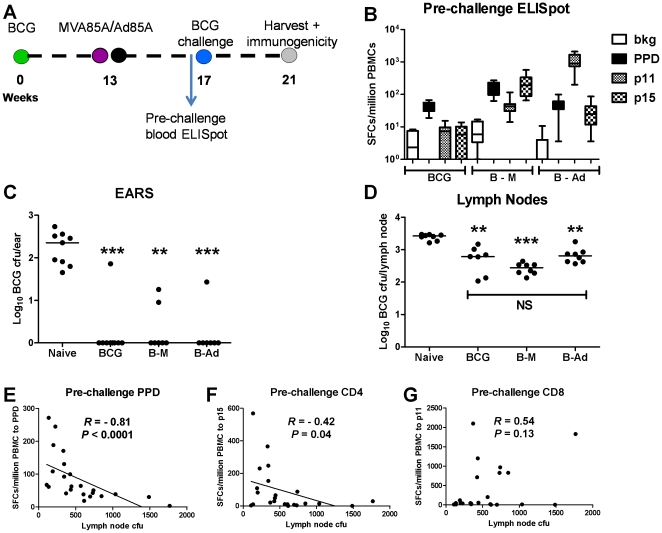
Effect of BCG, BCG-MVA85A (B–M), and BCG-Ad85A (B-Ad) prime-boost regimes on an id BCG challenge.Timeline shown in (a): BALB/c mice were immunized with 104 CFU BCG id and then boosted after 13 weeks with either 1×106 pfu MVA85A id or 2×109 vp Ad85A id. All animals were challenged 4 weeks later with 6×103 CFU of BCG id. Organs were harvested 4 weeks after challenge. Log10 BCG CFU of challenge are shown in (c) Ears (***P<0.001, **P<0.01, n = 8); and (d) LNs (***P<0.001, **P<0.01, n = 8, “NS” = no significant difference). **/*** indicate significance of immunization regimes over naïve mice. (b) Pre-challenge immunogenicity as measured in the blood by ELISpot. IFN-γ responses were assessed after stimulation with PPD, a H-2d CD4+ T cell epitope, and a H-2d CD8+ T cell epitope present in the M.tb antigen 85A, on blood samples taken one day pre- BCG challenge. IFN-γ responses within all three vaccinated groups (BCG (B), BCG-MVA85A (B-M), and BCG-Ad85A, (B-Ad), n = 10) are shown. Whiskers represent minimum to maximum values, boxes the interquartile range, and bars the median values for each group. Correlations between LN cfu and pre-challenge blood ELISpot responses to (e) PPD; (f) CD4+ epitope; and (g) CD8+ epitope. Spearman correlation analysis (with individual data-points for all 30 mice in the three vaccination groups) is shown.